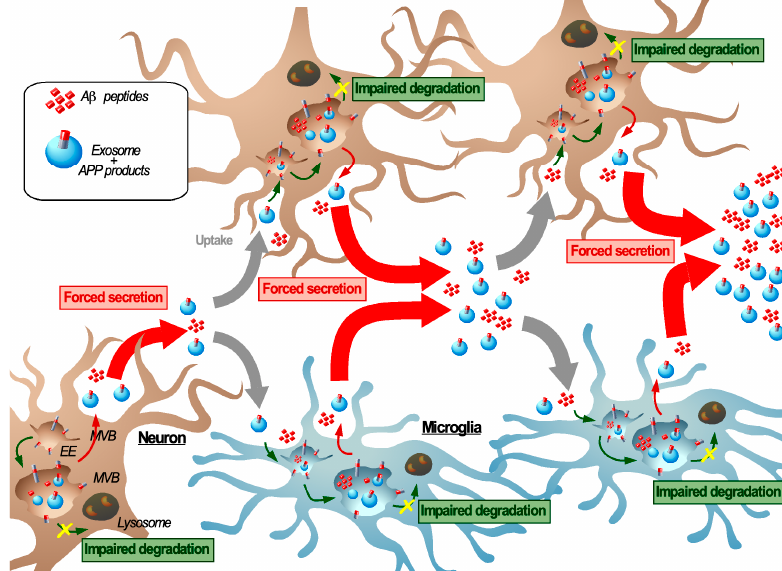
Figure 3. Transmissible endosomal intoxication. In neurodegenerative diseases such as Alzheimer ′ s disease, the imbalance between endosomal/autophagic degradation and secretion in neurons, induced or enhanced by C99 and A β 42 accumulation promotes their release either or not in association with exosomes. As a mechanism of defense, neighboring cells (including neurons, here indicated in brown and microglia indicated in blue) can engulf these amyloids and exosomes by endocytosis, which induces a new cycle of endosomal congestion and re-secretion of amyloids and can lead to the intercellular propagation of endosomal intoxication. Here, we propose a novel model to describe this self-sustaining cycle; transmissible endosomal intoxication (TEI) as a way by which amyloids are propagated over the course of disease